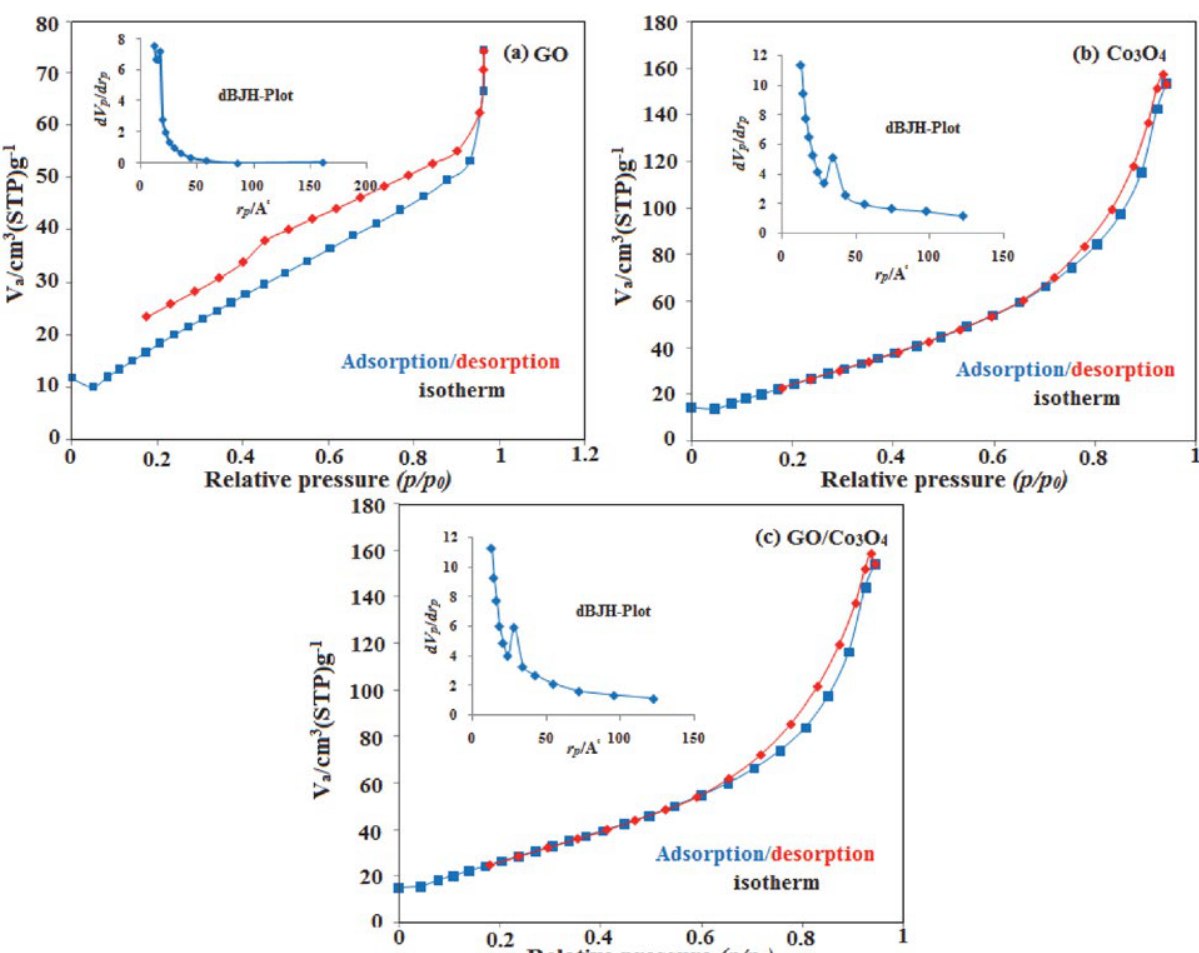
Figure 8. N adsorption–desorption isotherms of (a) GO, (b) Co 2 bution